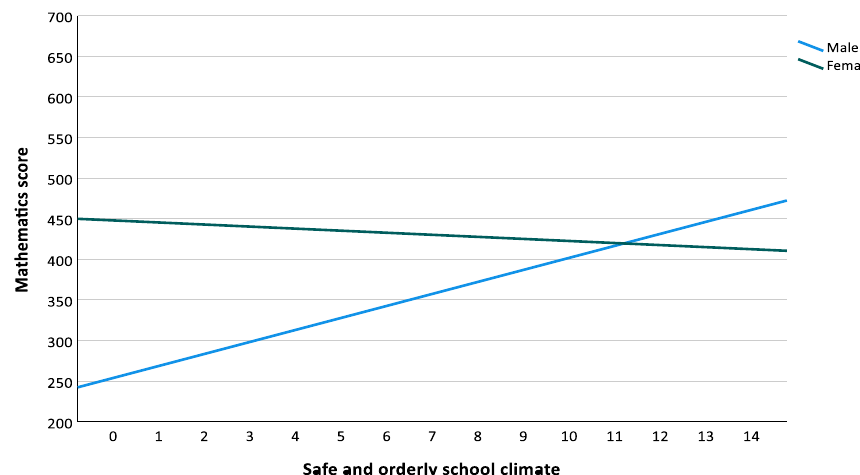
Fig. 2 Interaction between gender and safe and orderly school climate on mathematics achievement, grade 4. The plot presents the predicted values from step 7 of the mathematics model for grade 4 (Table 10)